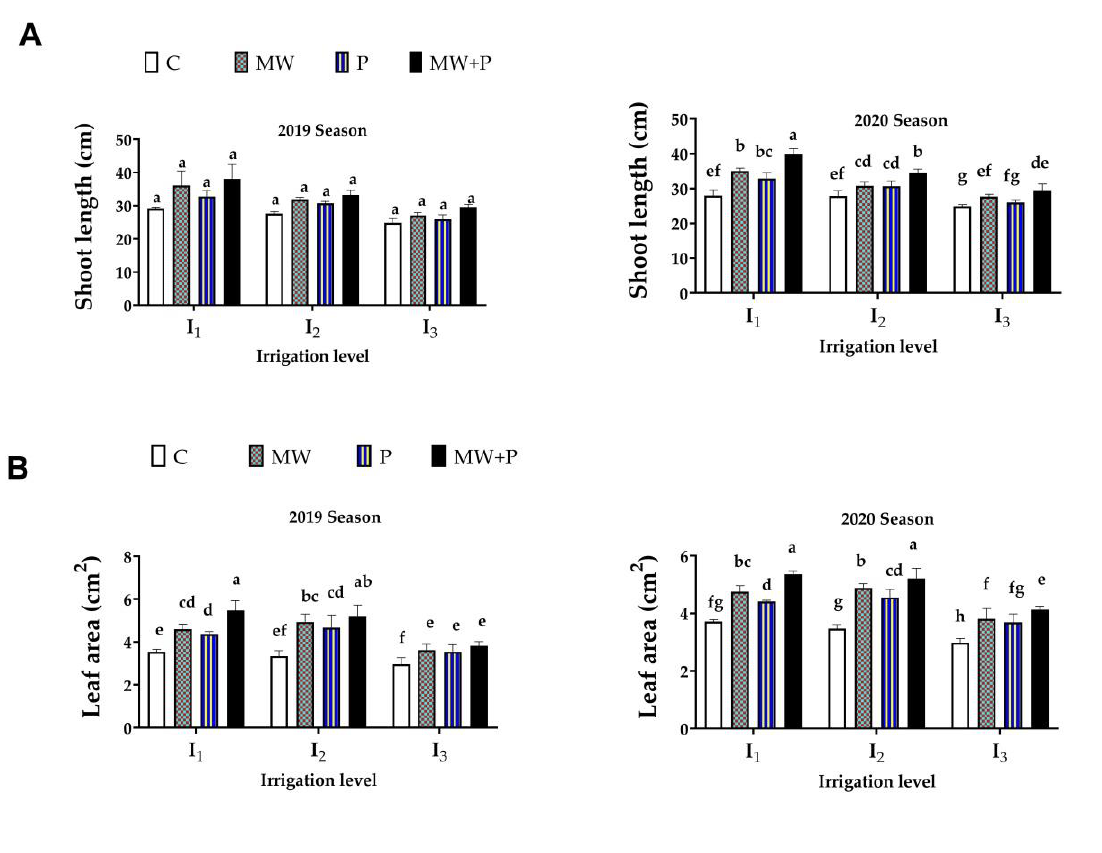
Figure 3. Effect of MW, P, and MW + P on shoot length ( A ) and leaf area ( B ) of “Taifi” pomegranate shrubs grown under different irrigation regimes (I 1 , I 2 , and I 3 ), based on CWR, during the 2019 and 2020 seasons. Values are the means ± SD. DMRT was used for mean comparisons at p ≤ 0.05.